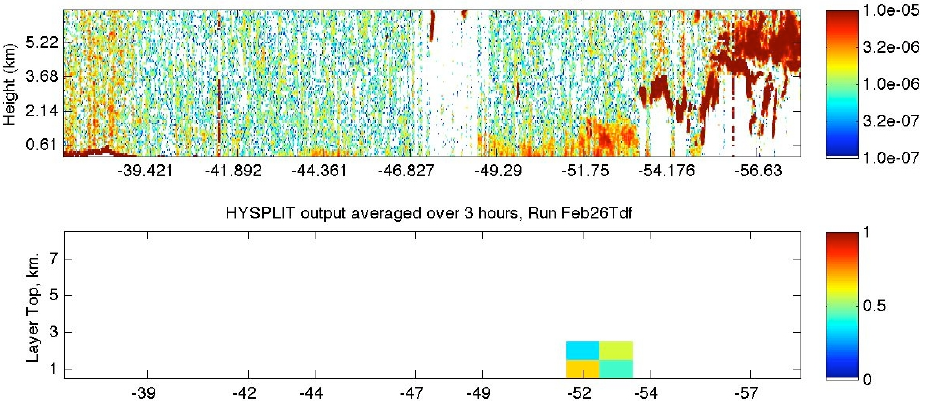
Fig. 8. Top Panel: GLAS 1064nm backscatter profiles for the low 6.6km. White=no signal, red=clouds, yellow and green; orange=aerosol. Bottom panel: normalized HYSPLIT concentrations for run TdF26, model run constrained by observations.